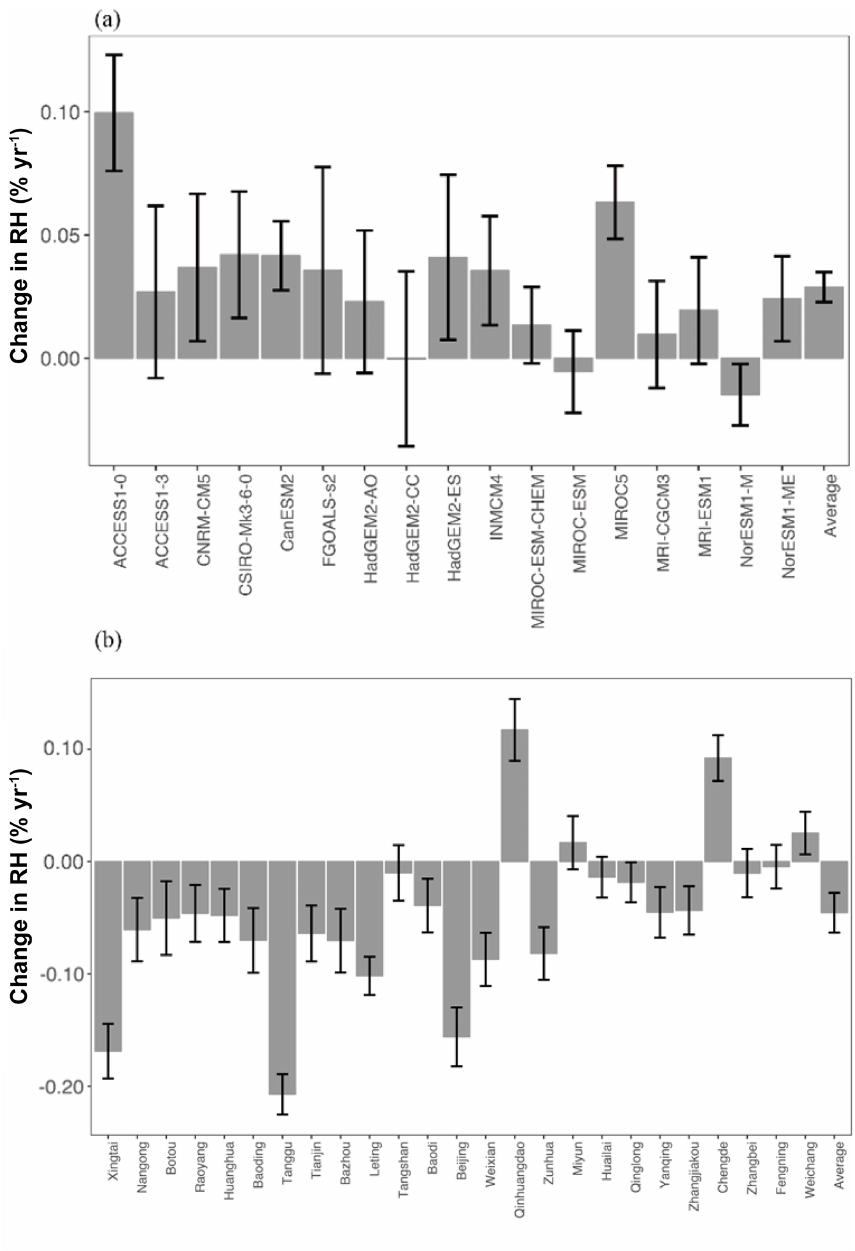
Figure 1. (a) Linear trends of annual average RH (in %yr − 1 ) in Beijing–Tianjin–Hebei (BTH), calculated for 1960–2017 historical simu- lations by an ensemble of 17 CMIP5 climate models; (b) same as (a) except derived from 25 China Meteorological Administration (CMA) meteorological stations in BTH